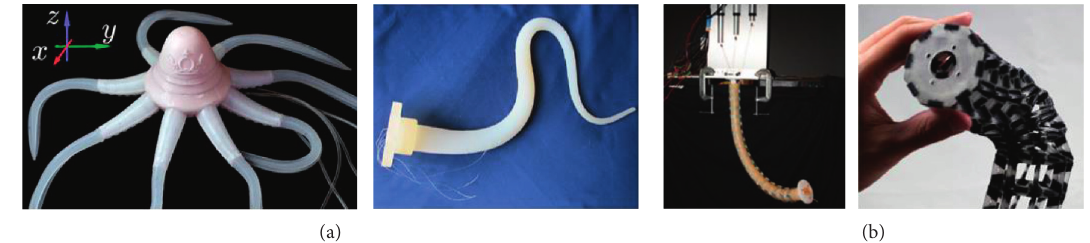
Figure 4: Continuum robots: octopus leg [77] (a) and tentacle inspired [90, 101] (b).